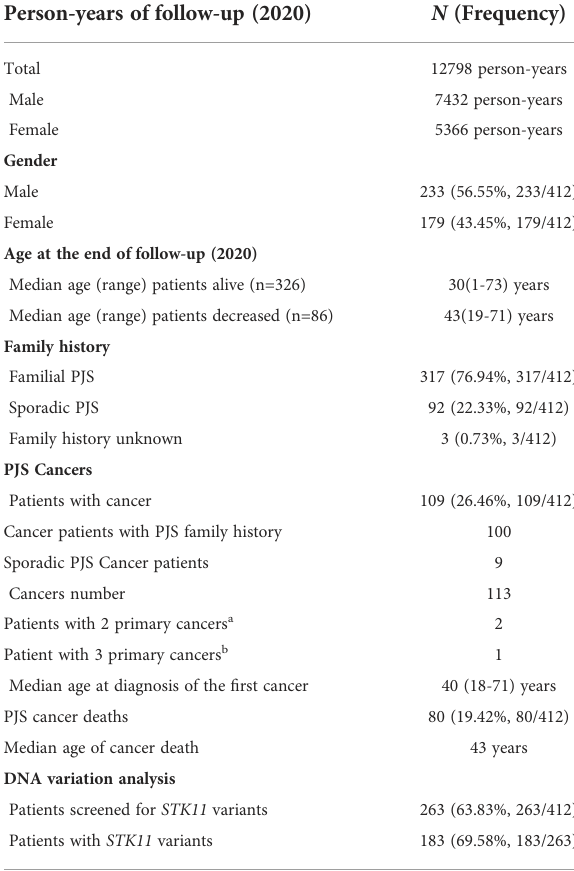
TABLE 1 Baseline characteristics of 412 Chinese PJS patients from 208 different